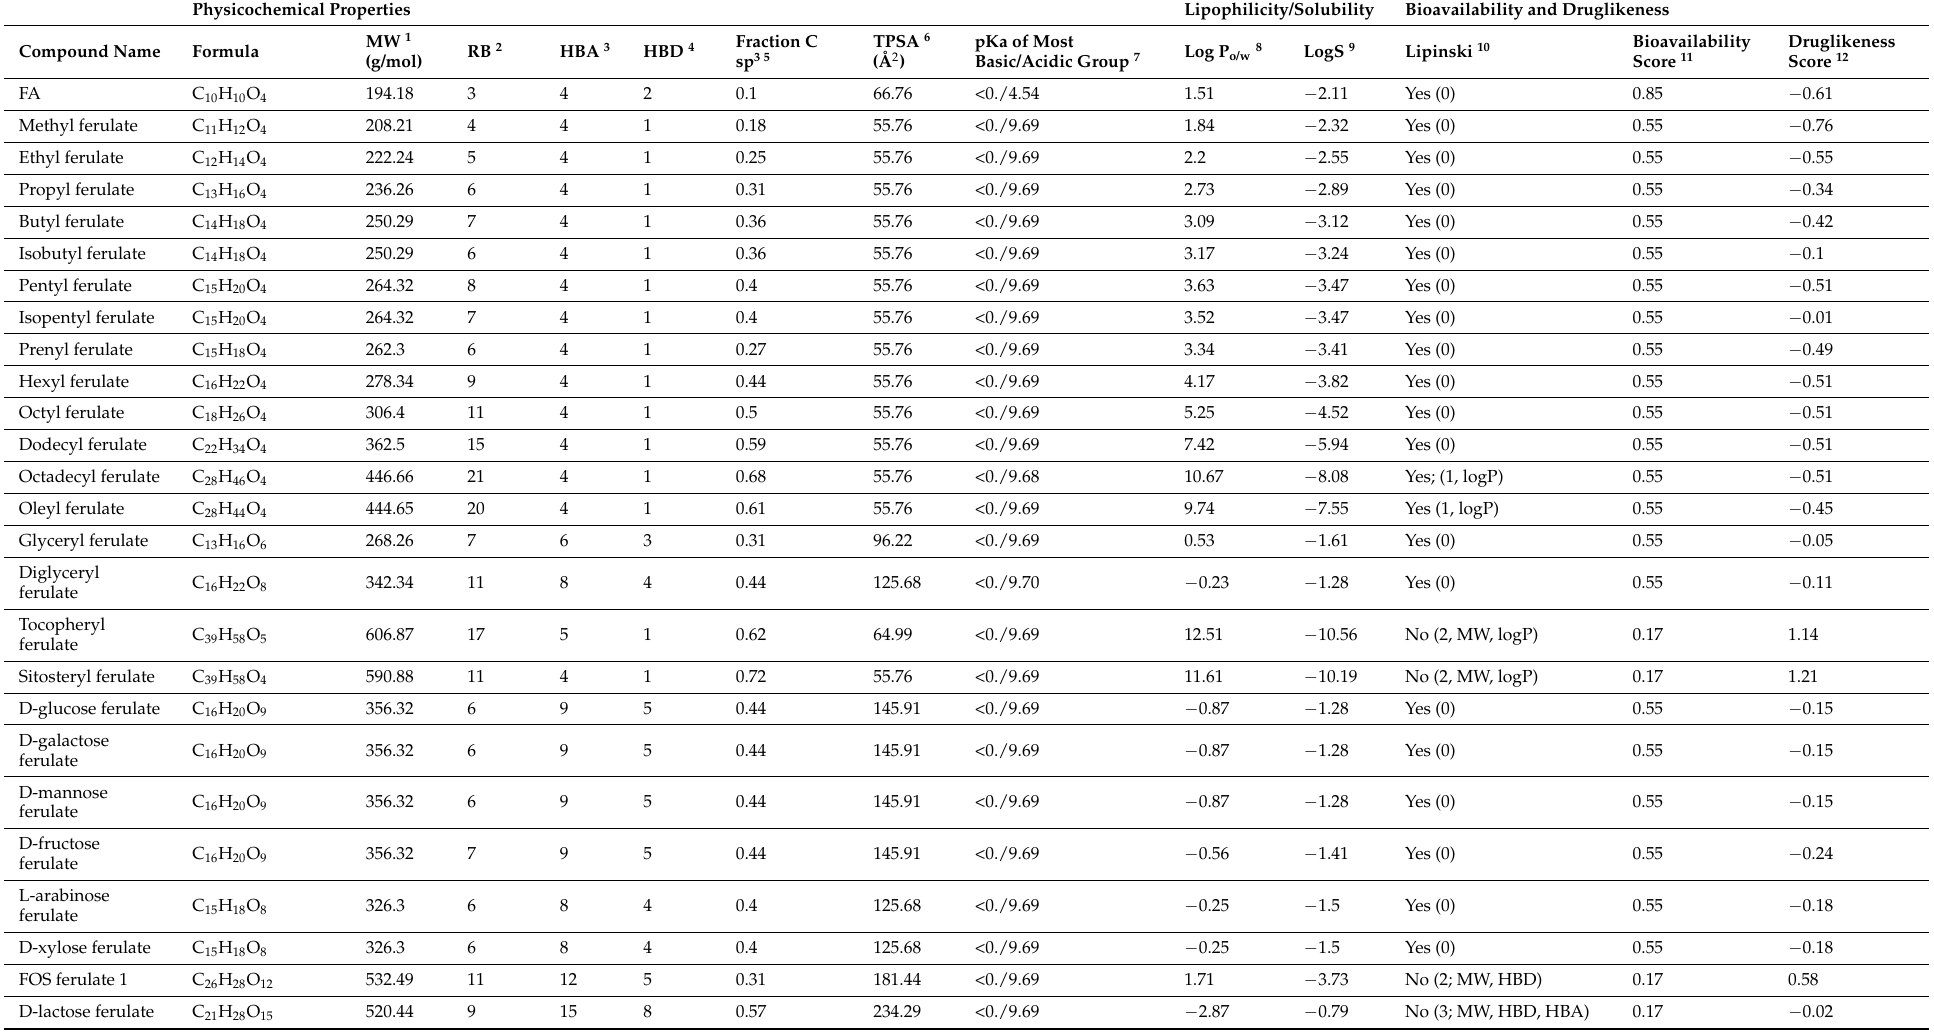
Table 5. Physicochemical properties, lipophilicity, solubility, bioavailability, and druglikeness predictions for FA and its selected